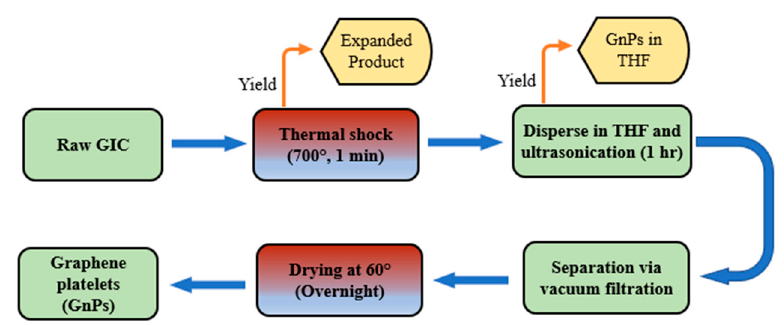
Figure 1. Preparation chart for graphene platelets to be ready for mixing with asphalt.